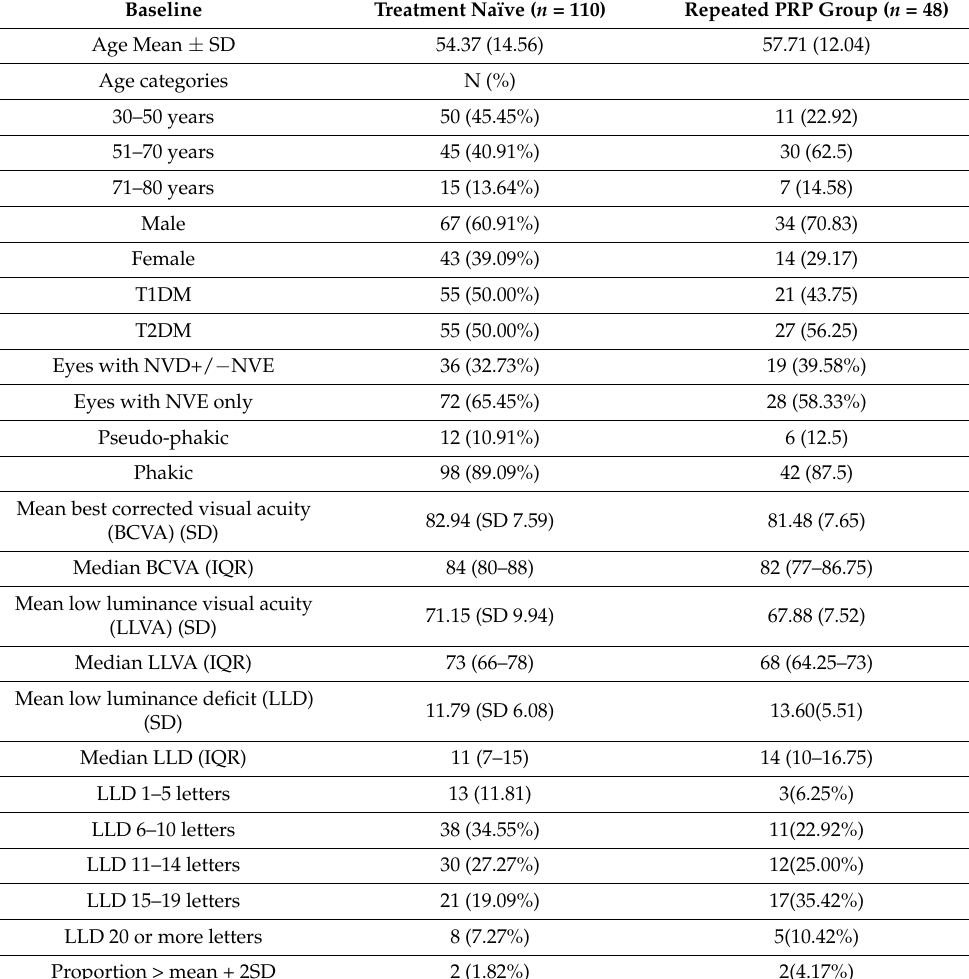
Table 1. Demographic characteristics of treatment naïve eyes at baseline.